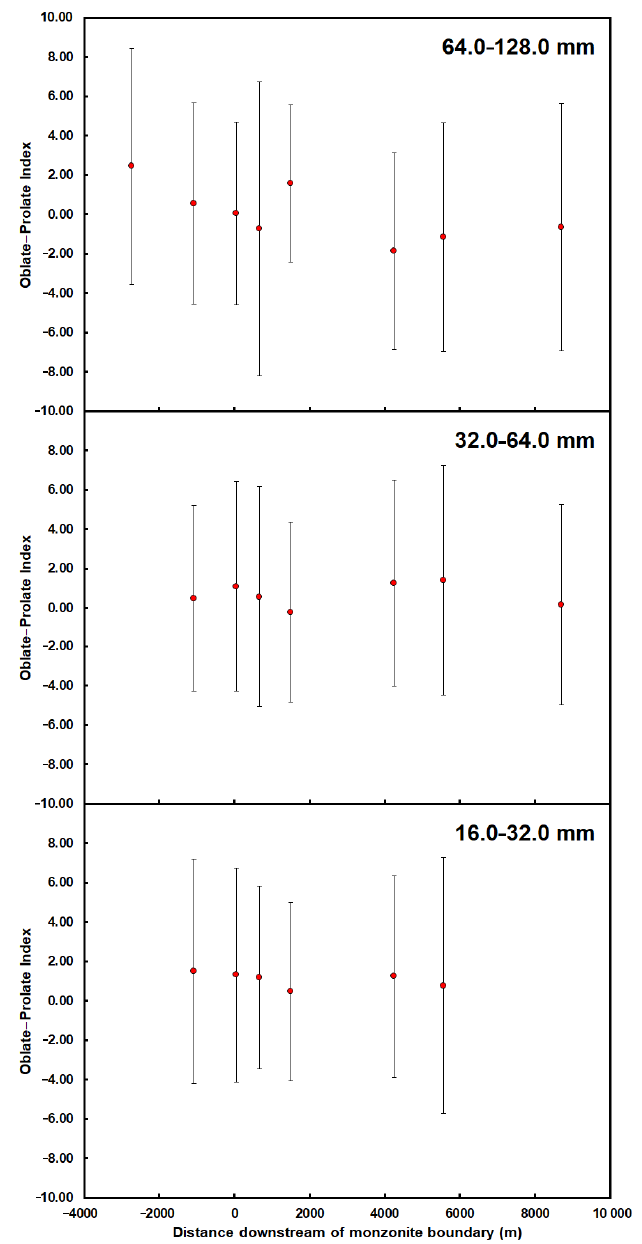
Figure 16. The mean Oblate–Prolate Index of gravels of Navilawa Monzonite as a function of distance downstream of the boundary of the monzonite intrusion in the Sabeto River of western Viti Levu, Fiji. The data points are expressed with an uncertainty of ±1 s .